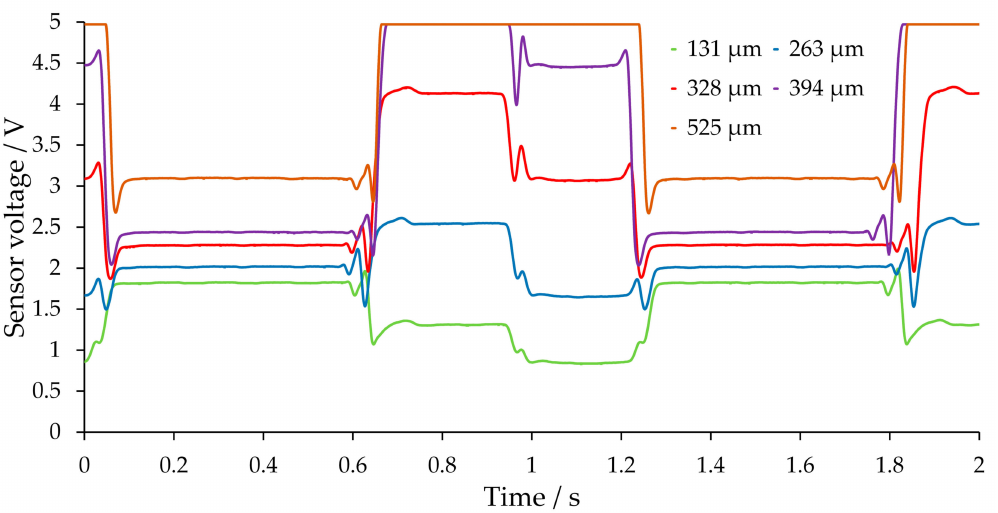
Figure 7. Measured voltages at di ff erent positions of the capillary relative to the phototransistor. The height is the distance between the lowest capillary position in the transmissive sensor and its actual position. Shown are positions from the bottom to an approximately centered position at 525 µ m. Plateaus: nitrogen (0.1–0.6 s and 1.3–1.8 s), water (0.6–1.0 s and from 1.8 s), 1-hexanol (up to 0.1 s and 1.0–1.3 s). The lengths of the plateaus show slight deviations due to deviations in bubble and slug length. The raw signal was processed with a moving average filter (see Section